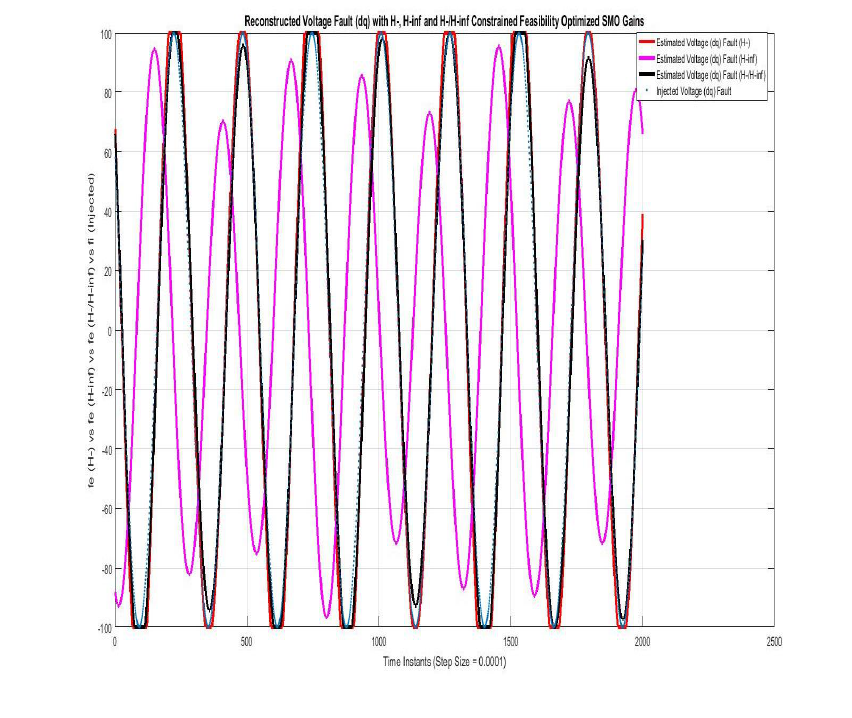
Figure 4. Reconstructed voltage fault (dq) with feasibility optimized ( H − ) and H − / H ∞ SMO gains.